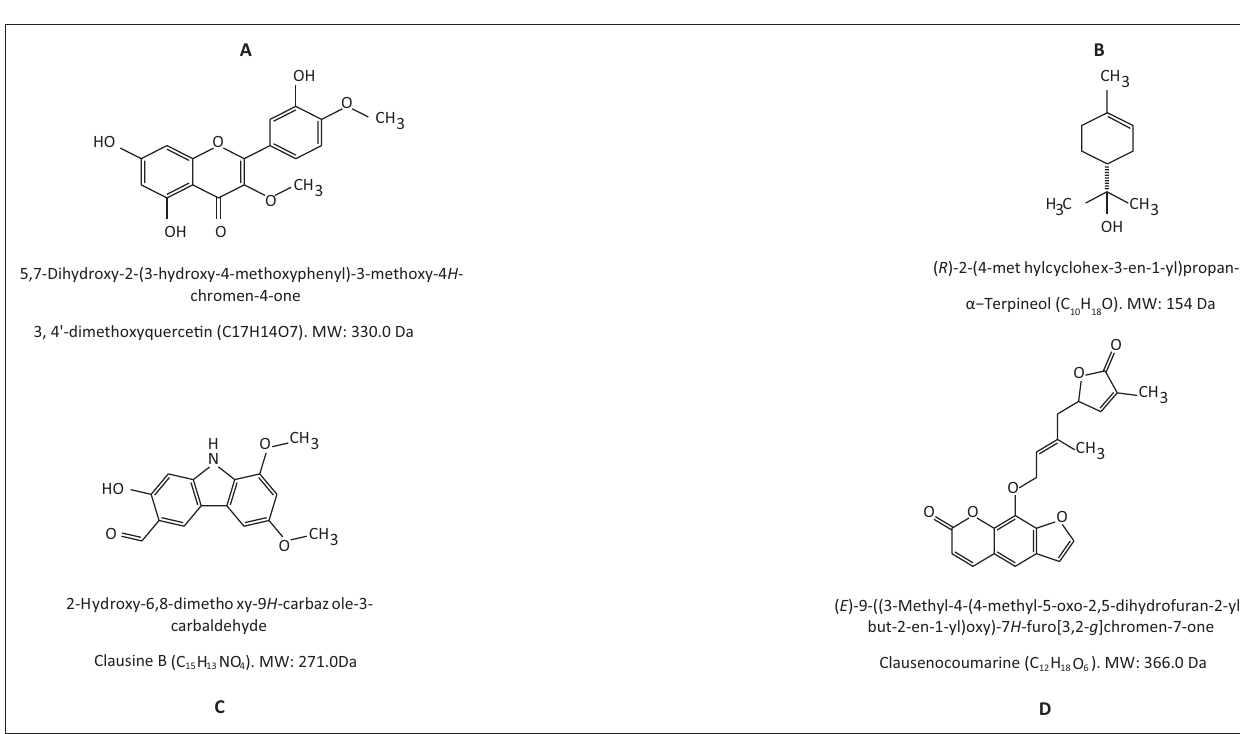
FIGURE 6: Structures of phenolic compounds in the acetone leaf extracts identified by liquid chromatography–mass spectroscopy. MW, molecular